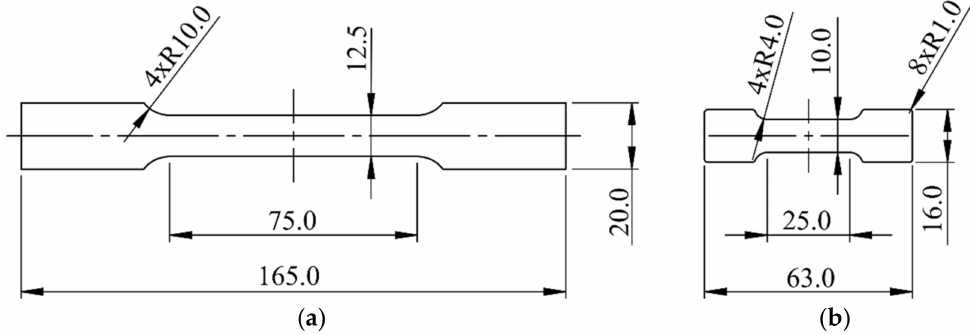
Figure 6. Samples for the tensile tests: ( a ) standard sample (PN-EN 10002-1+AC1); ( b ) modified (minimized)